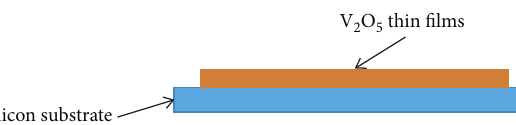
Figure 1: V 2 O 5 thin film deposition using